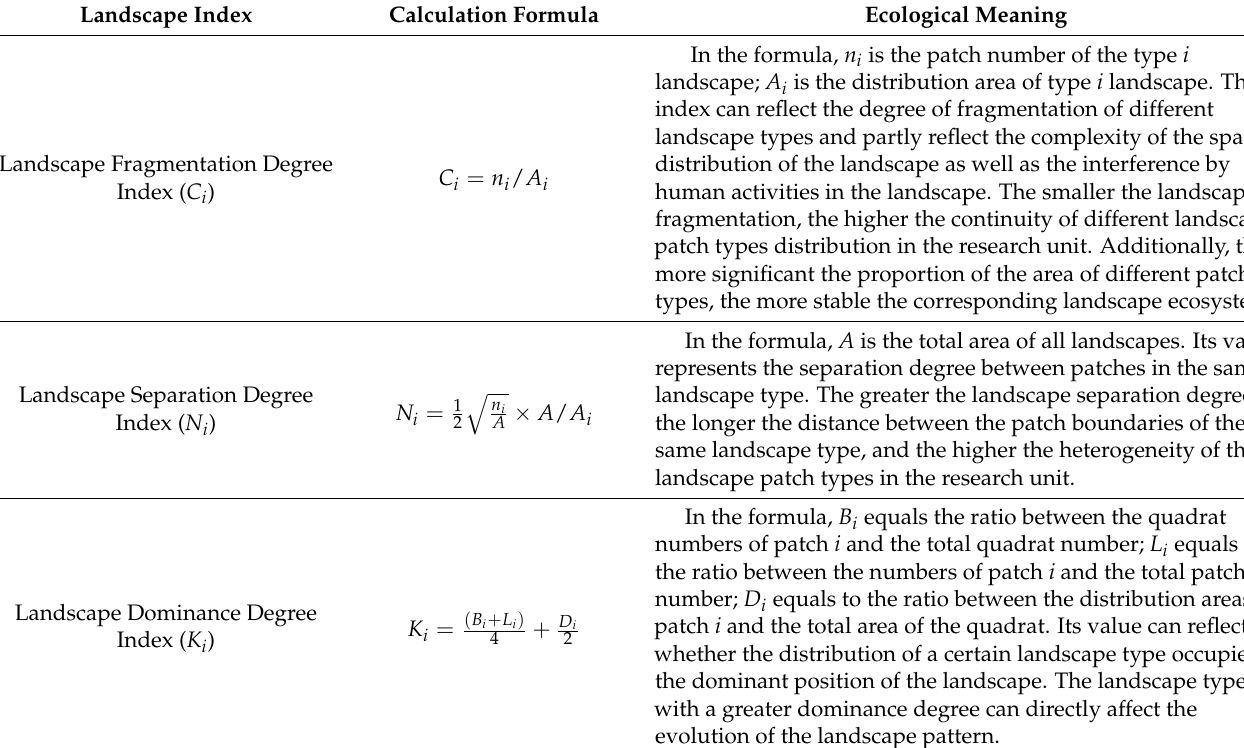
Table 2. The construction method of landscape pattern